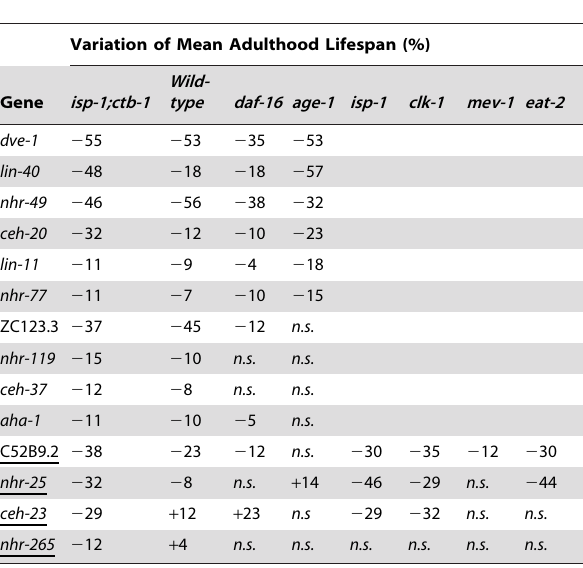
Table 2. Genetic interaction analyses of the RNAi candidates in several longevity mutant